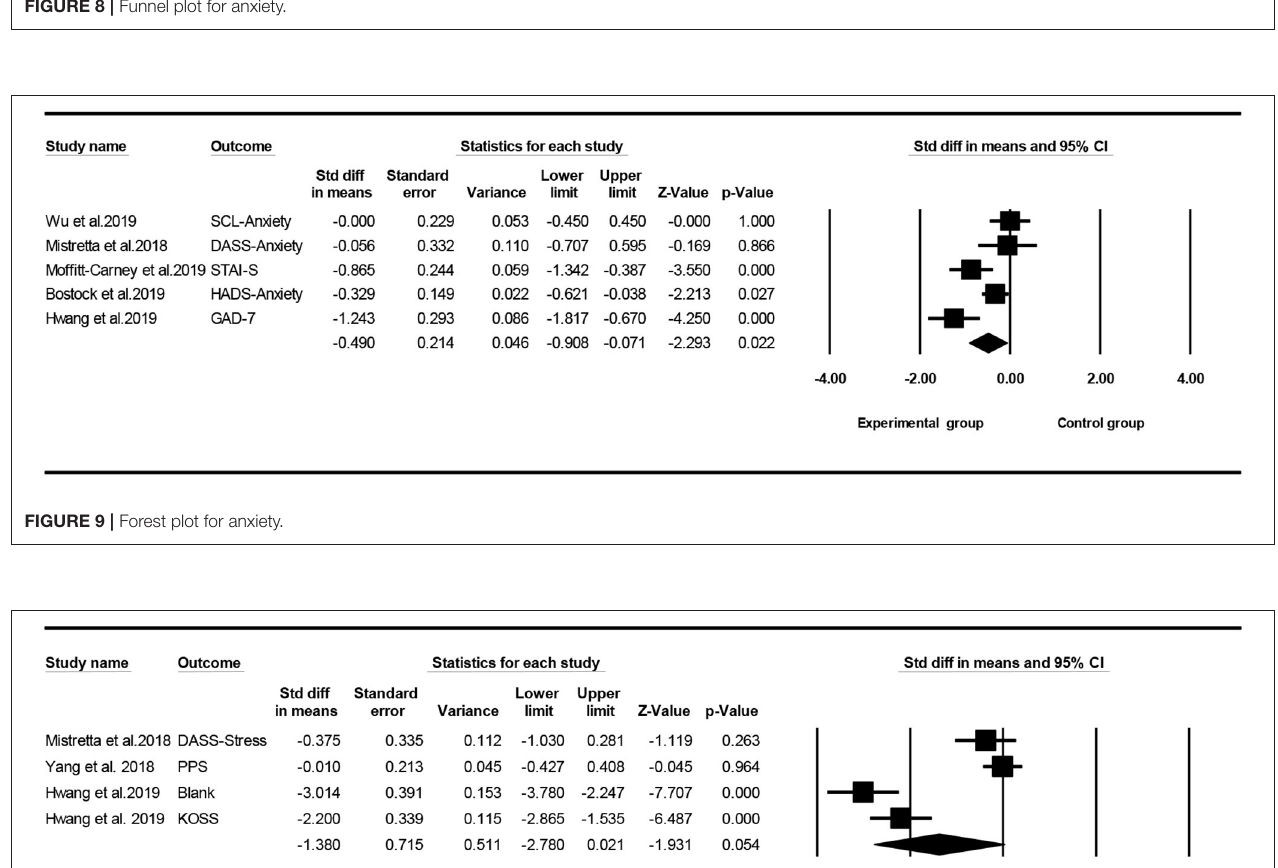
FIGURE 8 | Funnel plot for anxiety.